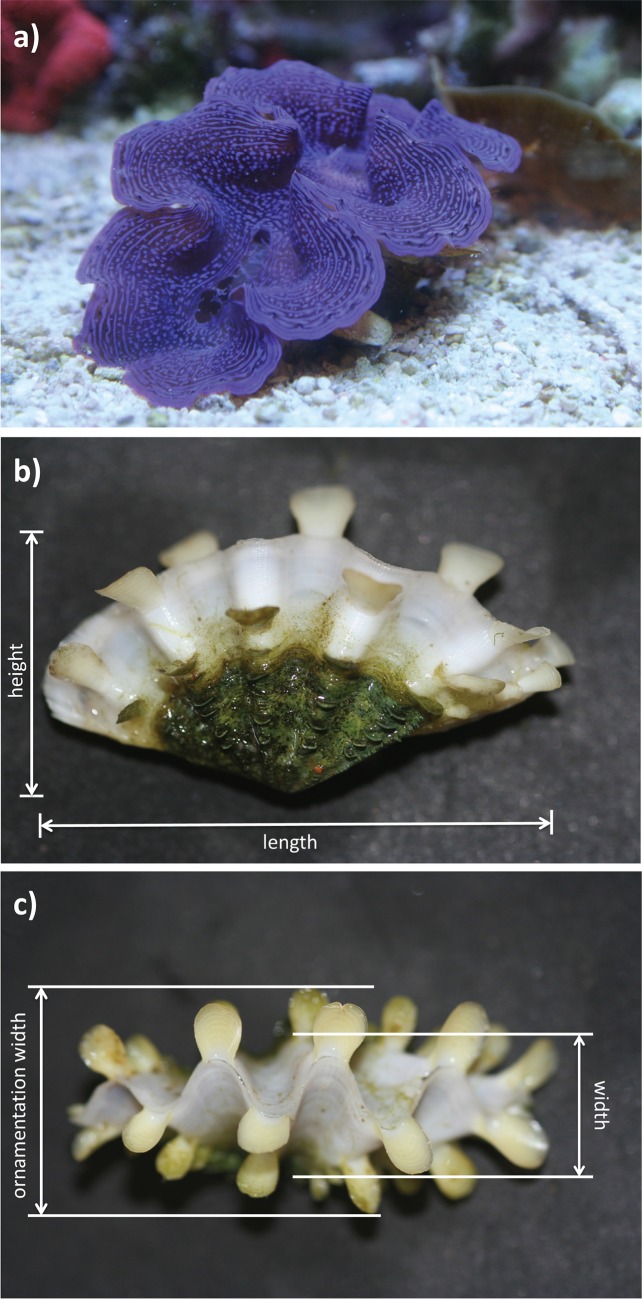
Giant clam shell measurements.Fluted giant clam Tridacna squamosa juvenile a) with mantle out, and b) and c) showing shell dimensions measured: length (anterior-posterior measurement), height (dorso-ventral measurement), width including ornamentation and width excluding ornamentation.